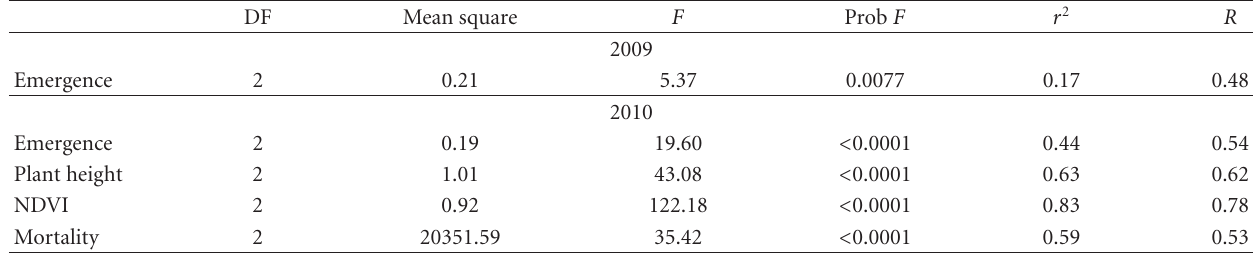
Table 3: Results from quadratic least squares regression when evaluating the e ff ect of soil pH on grain sorghum emergence, plant height, NDVI, and mortality (2009 and 2010).